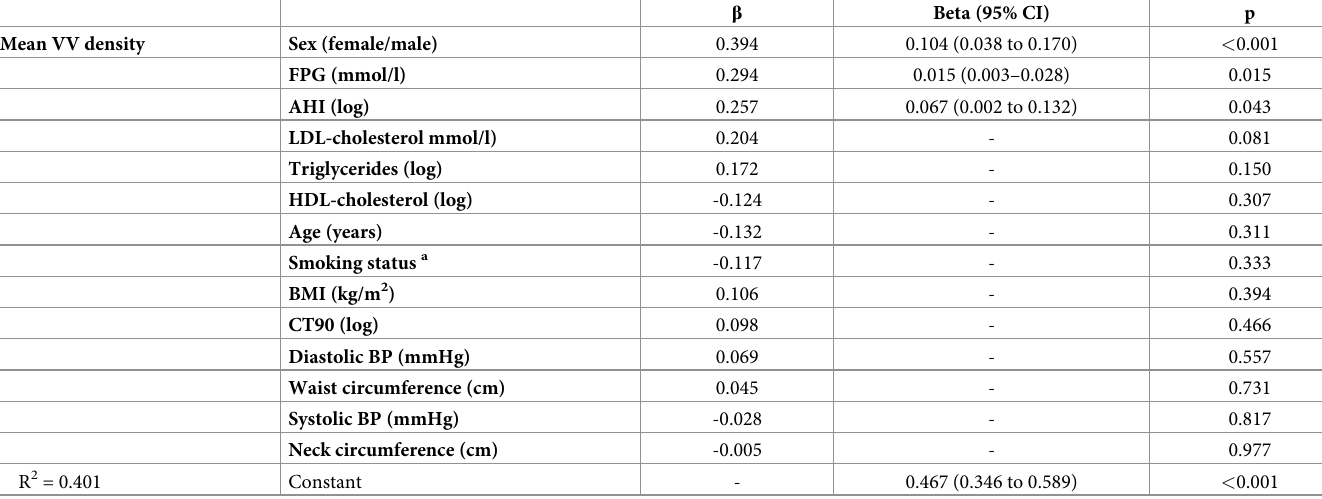
Table 3. Stepwise multiple linear regression analysis of variables associated with the mean adventitial VV